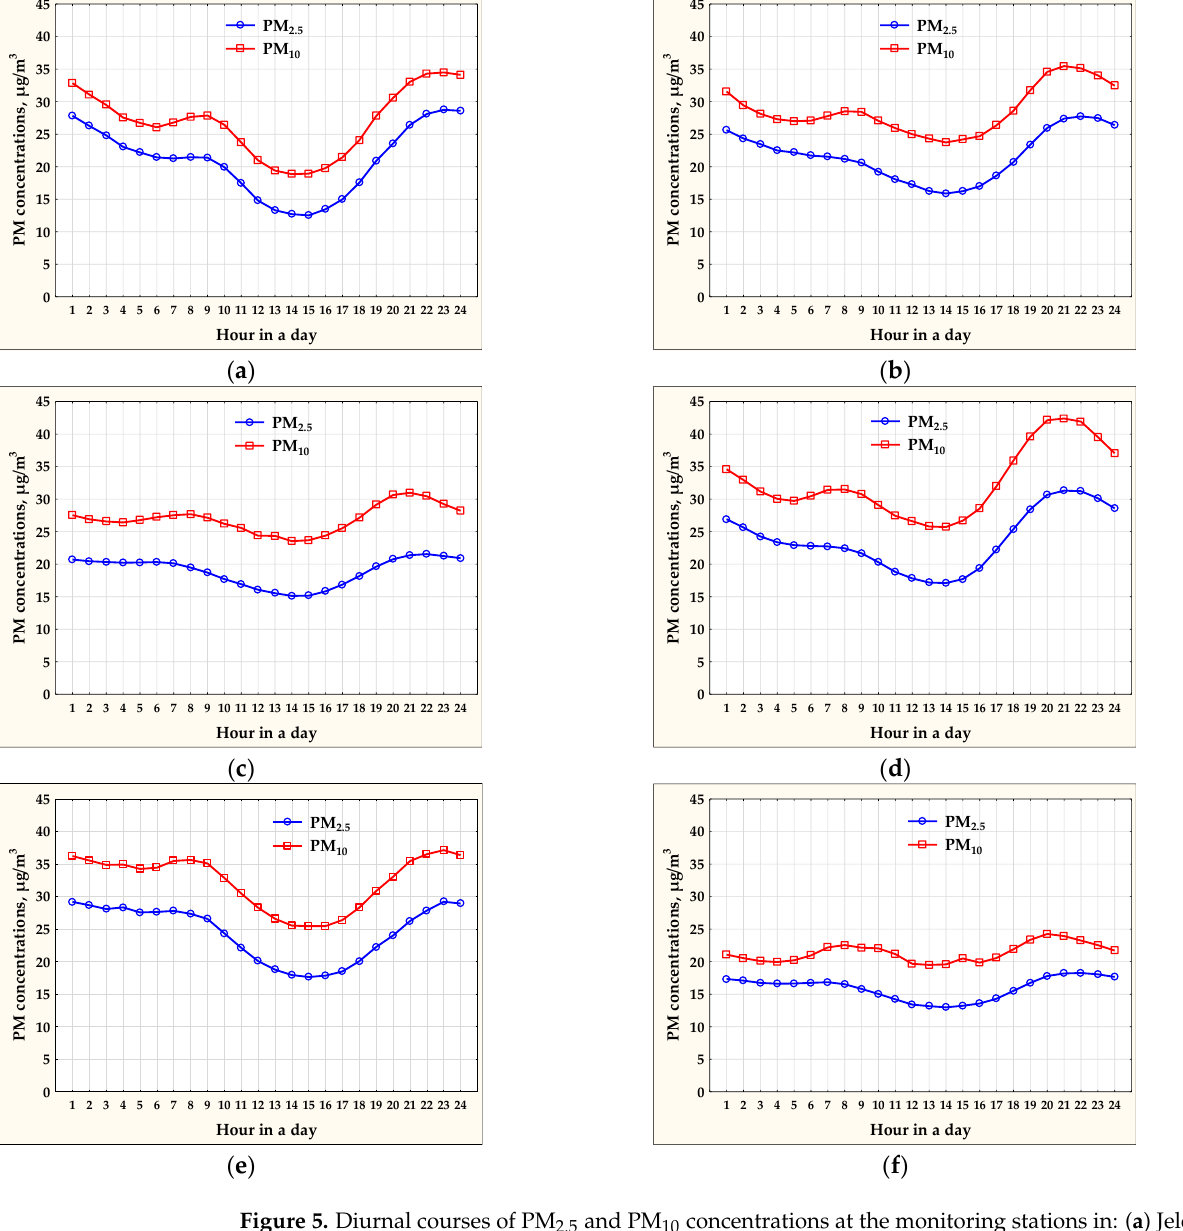
Table 4. Pearson’s correlation coefficient for variables registered at the air monitoring station s, 2015 – 2021.